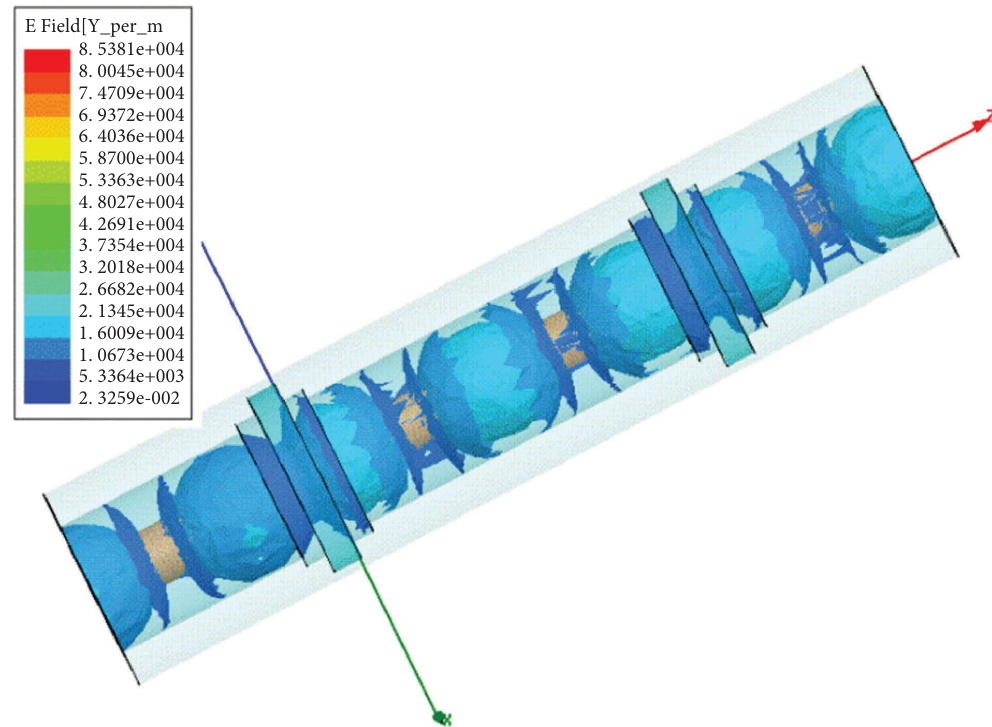
Figure 4: Finite element microwave simulation of the connector.